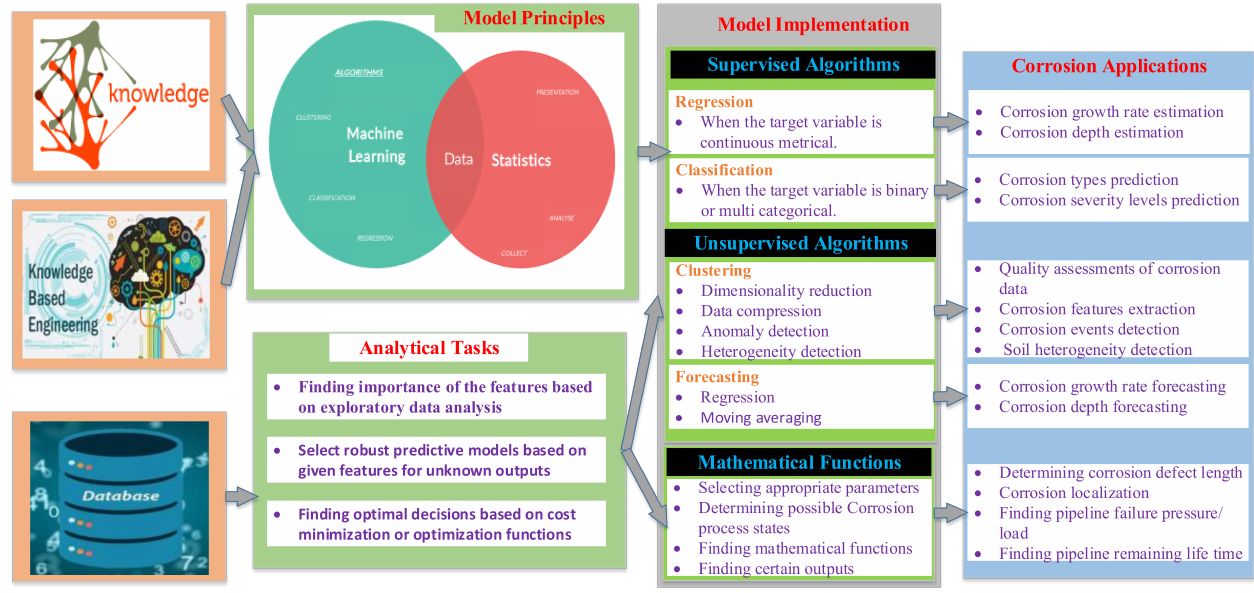
Figure 16. Diagram of data-driven corrosion modelling and its